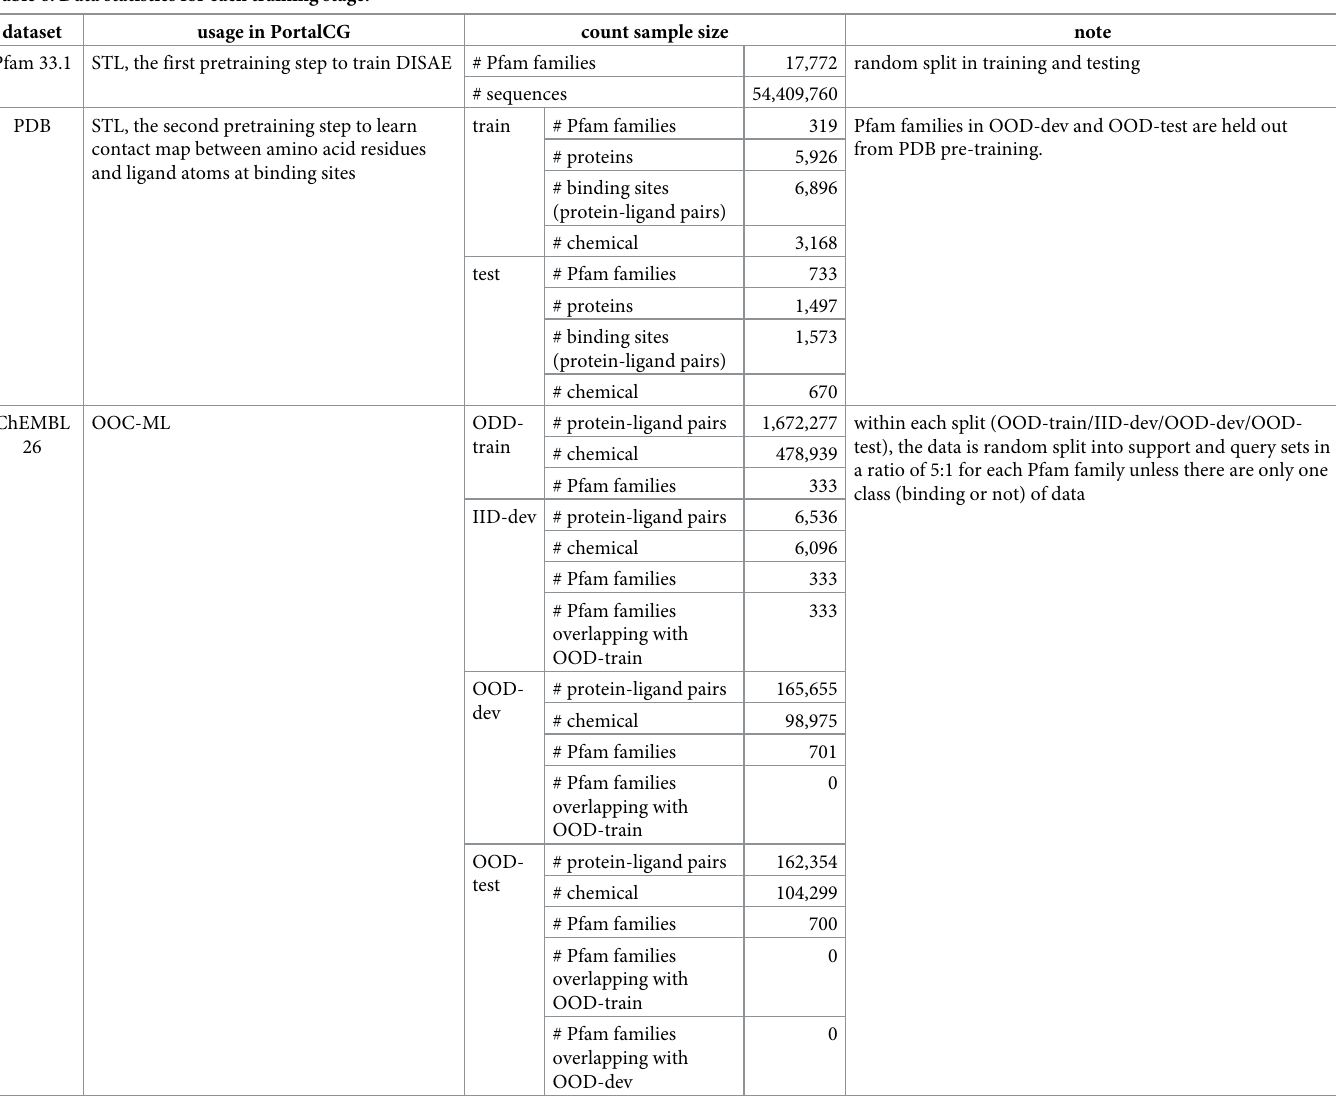
Table 6. Data statistics for each training